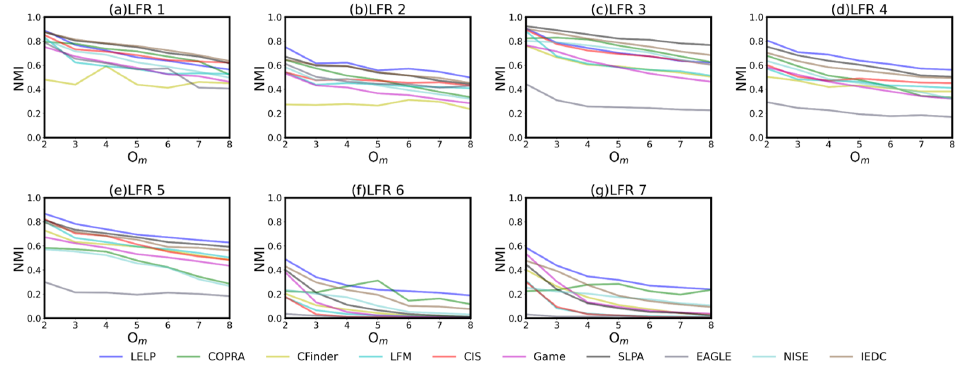
Figure 4. Sub figure ( a – g ) represent the NMI of different algorithms in the same LFR . NMI focus only on providing the measure of overlapping size in each